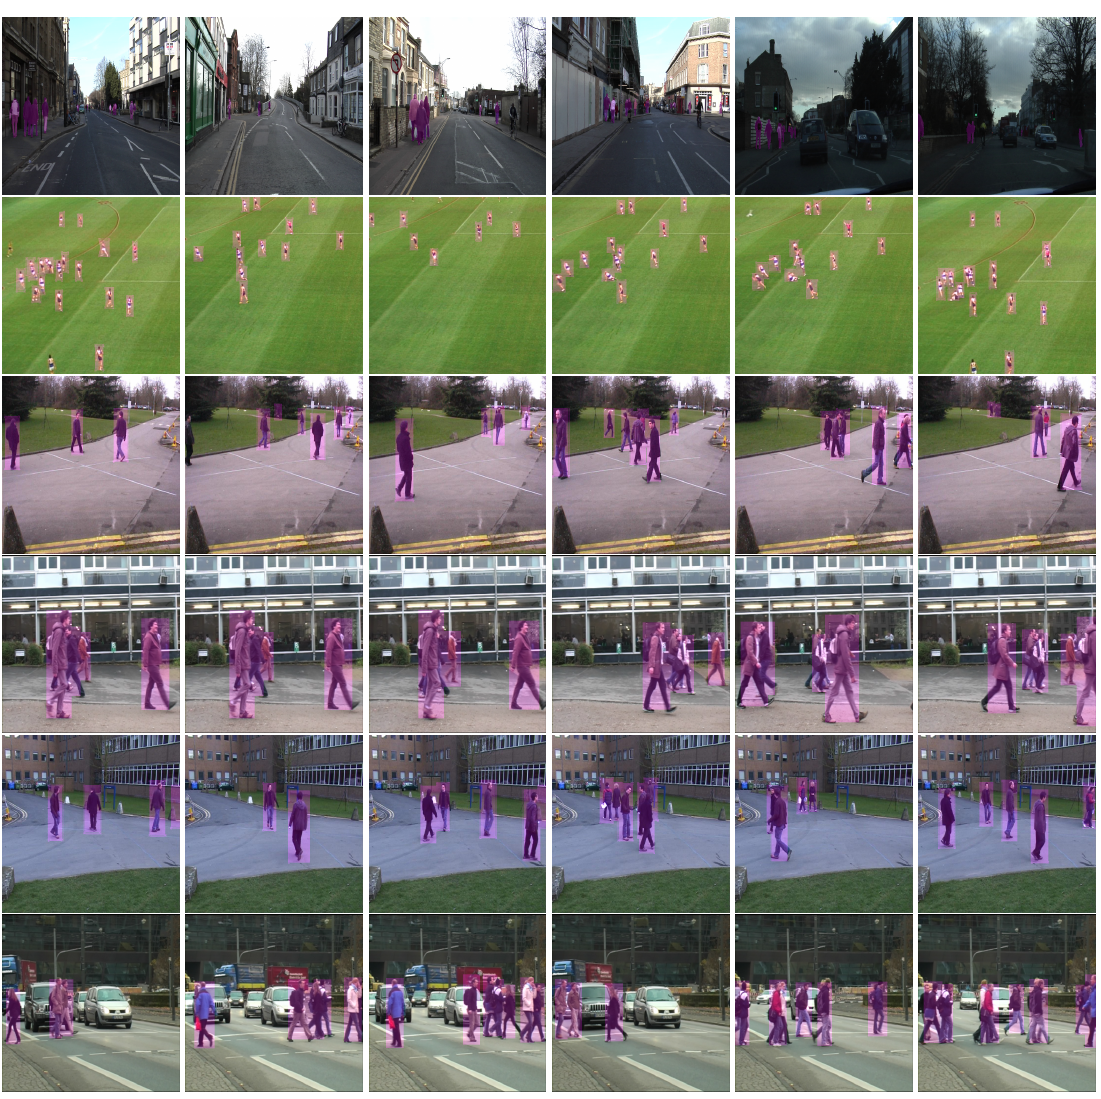
Figure 2. Qualitative results of our PedNet on 8 Challenging datasets. The row 1, 5, and 7 shows Pets2009 [36] dataset that is the commonly used for tracking. Second, sixth and the eighth row corresponds to TUD [37,38] dataset which is also used for evaluating tracking algorithms. The third row shows CamVid [39] dataset which is used for segmentation. The fourth row shows AFL [40] dataset which is used for tracking sports